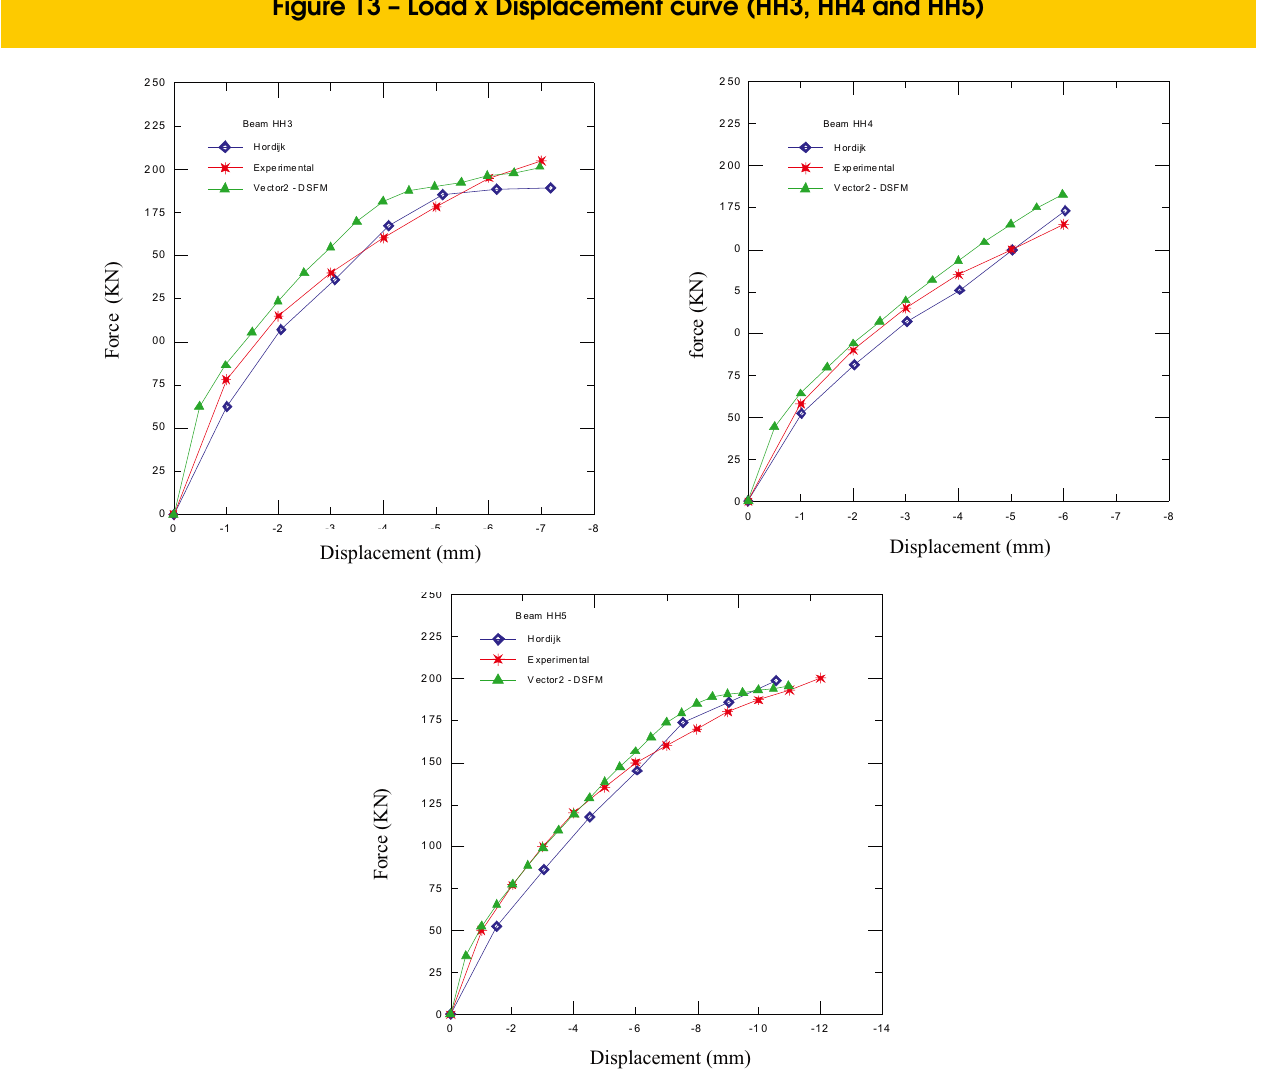
Figure 13 – Load x Displacement curve (HH3, HH4 and